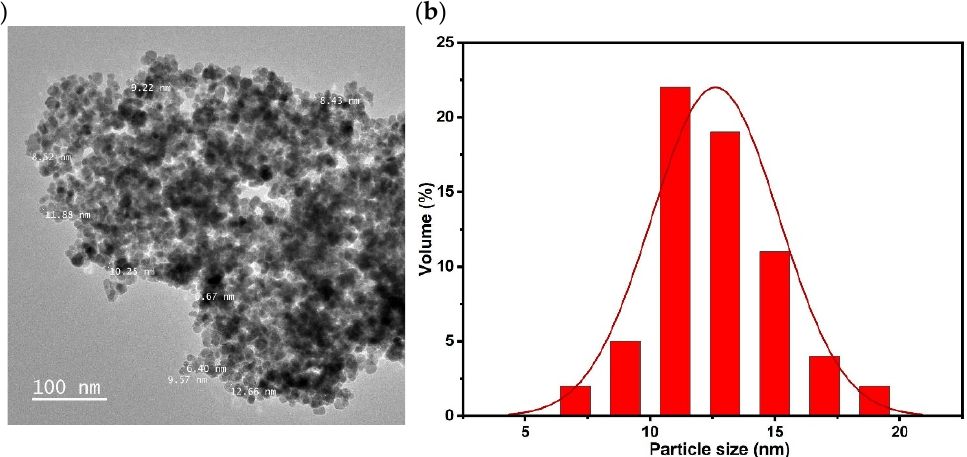
Figure 4. ( a ) TEM image and ( b ) size distribution of SPIONs synthesized at 80 °C in pH 11.